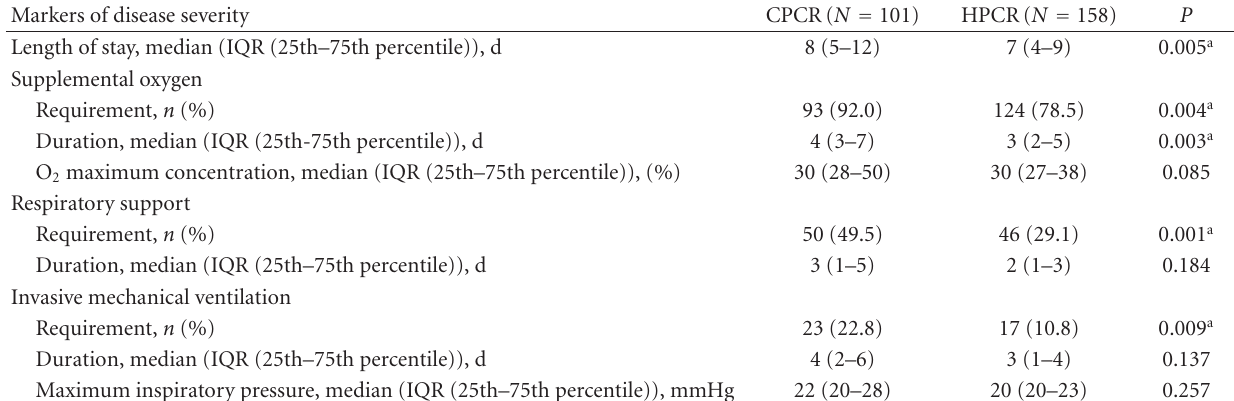
Table 2: Disease characteristics in infants hospitalized in NICU with an RSV newborns presenting a CPCR versus HPCR pattern. Markers of disease